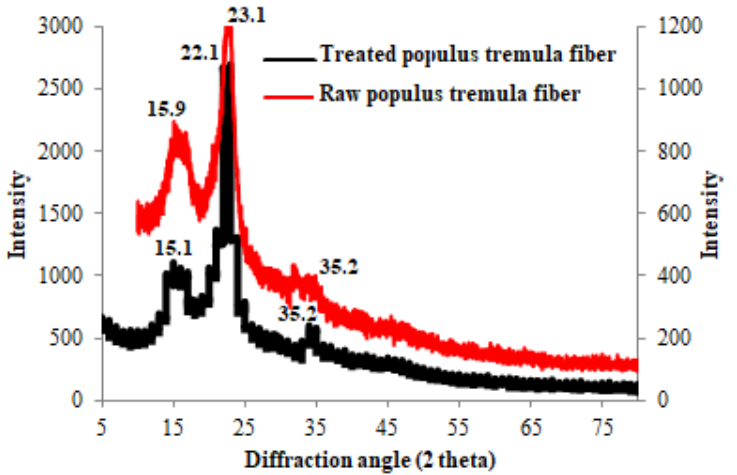
Figure 3. XRD patterns of untreated populus tremula fibers and extracted cellulose.